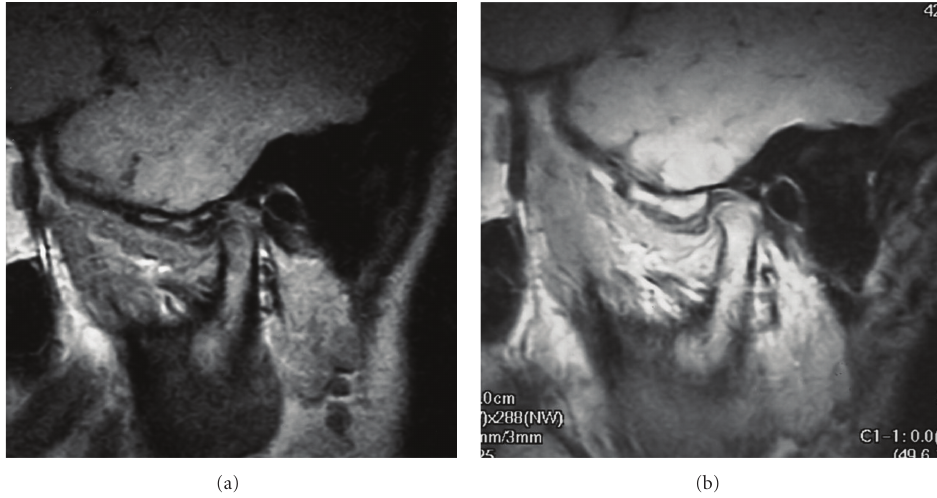
Figure 4: Di ff erences in the MRI signal within the articular eminences and mandibular condyles. (a) Morphology of the articular eminences and glenoid fossa of TMJ on MRI is in conformity with the outline of the mandibular condyles on fast spin-echo intermediate-weighted images of a healthy 10-year-old boy at the first examination. MRI signal of the articular eminence was yellow marrow, but that of mandibular condyle was red. The imaging parameters used in the MR sequences included 1050 ms TR, 15ms e ff ective echo time, flip angle of 90 ◦ , a 15 × 15cm field of view, a matrix of 160 × 288 pixels, 17mm slab thickness, and 3mm section thickness. (b) Morphology of the articular eminences and glenoid fossa of TMJ on MRI is in conformity with the outline of the mandibular condyles on the second examination three years after the first examination in the same subject as Figure 4(a). MRI signal of the articular eminence was of yellow marrow, and that of the mandibular condyle was also yellow marrow. The imaging parameters used in the MR sequences included 1050 ms TR, 15 ms e ff ective echo time, flip angle of 90 ◦ , a 15 × 15cm field of view, a matrix of 160 × 288 pixels, 17 mm slab thickness, and 3mm section